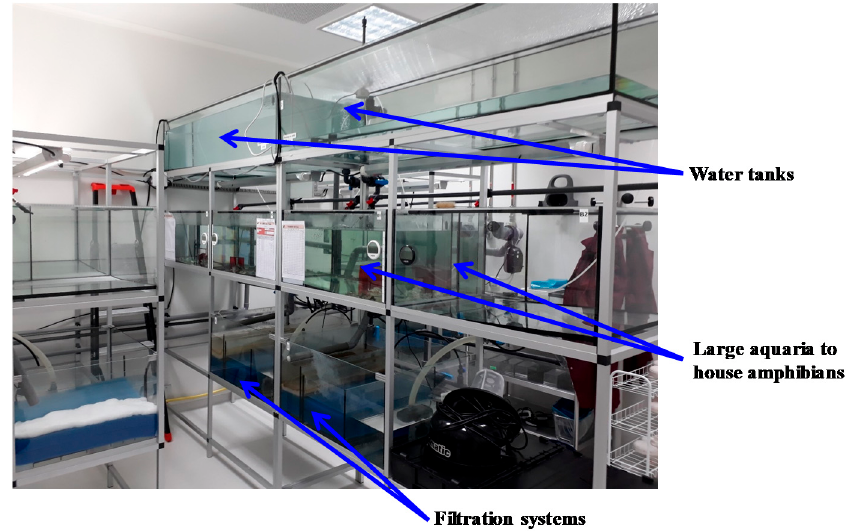
Figure 8. Amphibian housing area of the ACBS animal facility. Both adults and embryos/tadpoles can be reared in this sector under controlled